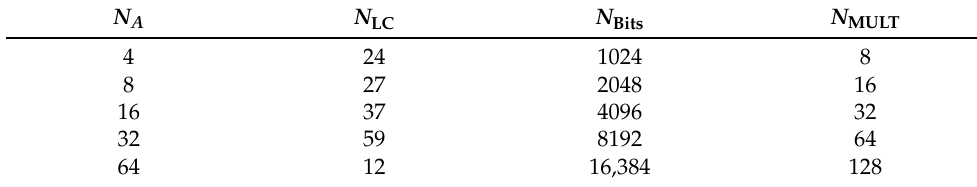
Table 3. Area occupation for the IM.